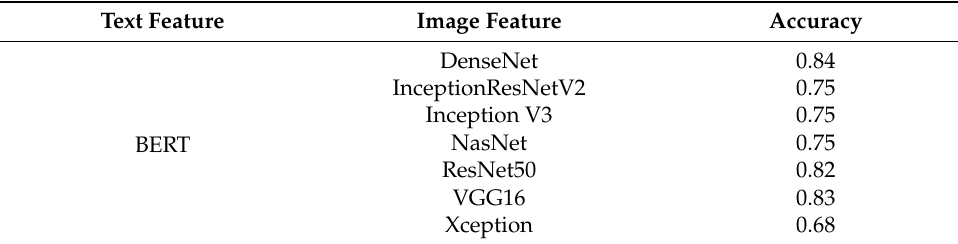
Table 7. Comparison of accuracy in the single task learning.